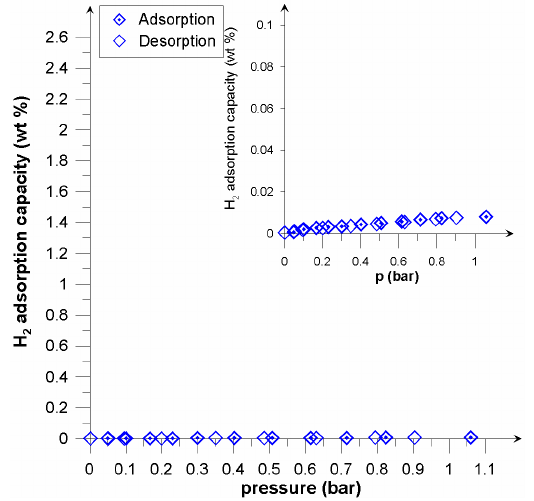
Figure 6. Adsorption/desorption isotherms of hydrogen on Picazine at 300 K.